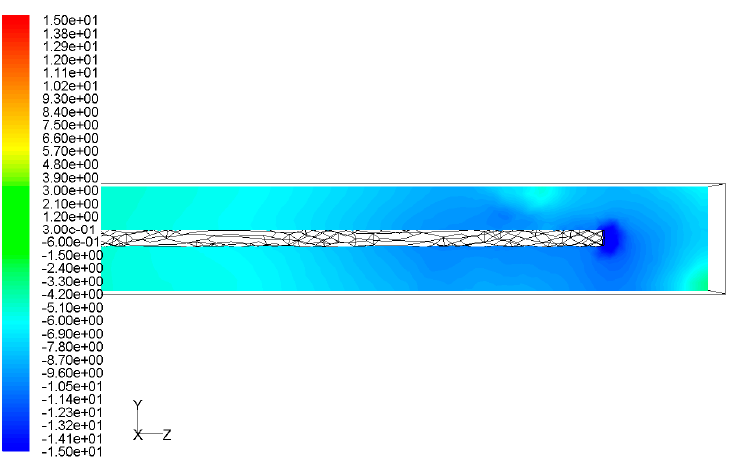
Figure 8. Pressure contour 2 m from the side wall (Pa).